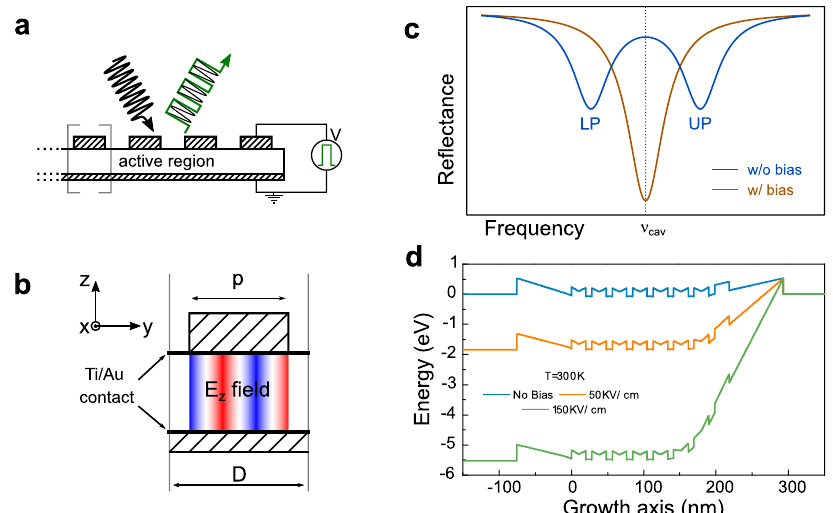
Fig. 1 Modulation operating principle. a Sketch of the modulator geometry: the active region is embedded in a metal – metal structure. By applying on it an external bias, the amplitude of the re fl ected beam is modulated. b Close-up of a single 1D ribbon of the device. p is the patch side, D the period. Two Schottky contacts permit the effective application of an external bias to the hetero- structure. The electric- fi eld distribution (z-component) of the TM 03 mode is also sketched. TM 0 i refers to the mode with i nodal lines in the y-direction. c Intuitive view of the modulator operating principle in an ideal con fi guration: with no applied bias the system is designed to be in strong coupling. Two polaritonic branches are visible in the re fl ectance spectrum, for a speci fi c value of the patch side p. By applying a speci fi c bias we can deplete an arbitrary number of quantum wells and bring the system in the weak- coupling regime: the bare cavity TM 03 mode is visible on the re fl ectance spectrum. d Conduction band pro fi le obtained by solving the Schrodinger – Poisson equation (NextNano ++ 24 ) at room-temperature with increasing external bias. No bias (solid blue line), 1.84 V (orange solid line) and 5.52 V (green solid